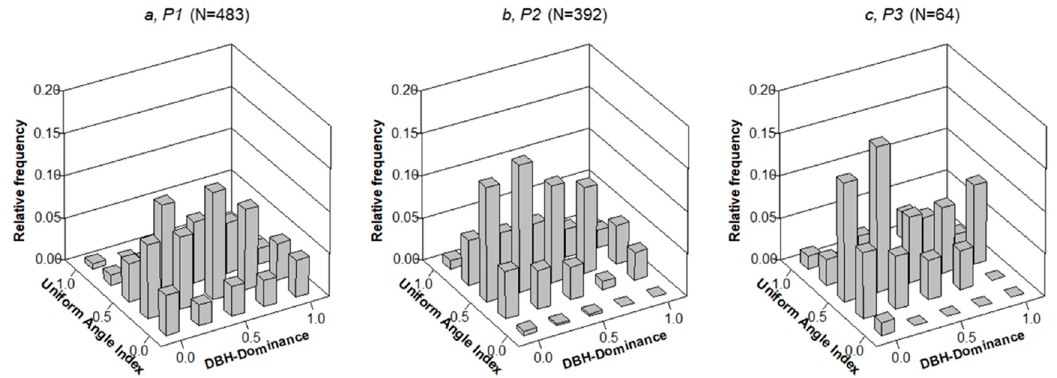
Figure 6. Bivariate distributions of the uniform angle index versus DBH dominance on three sample plots P1 ( a ), P2 ( b ) and P3 ( c ). N: number of S. macrophyllus individuals.